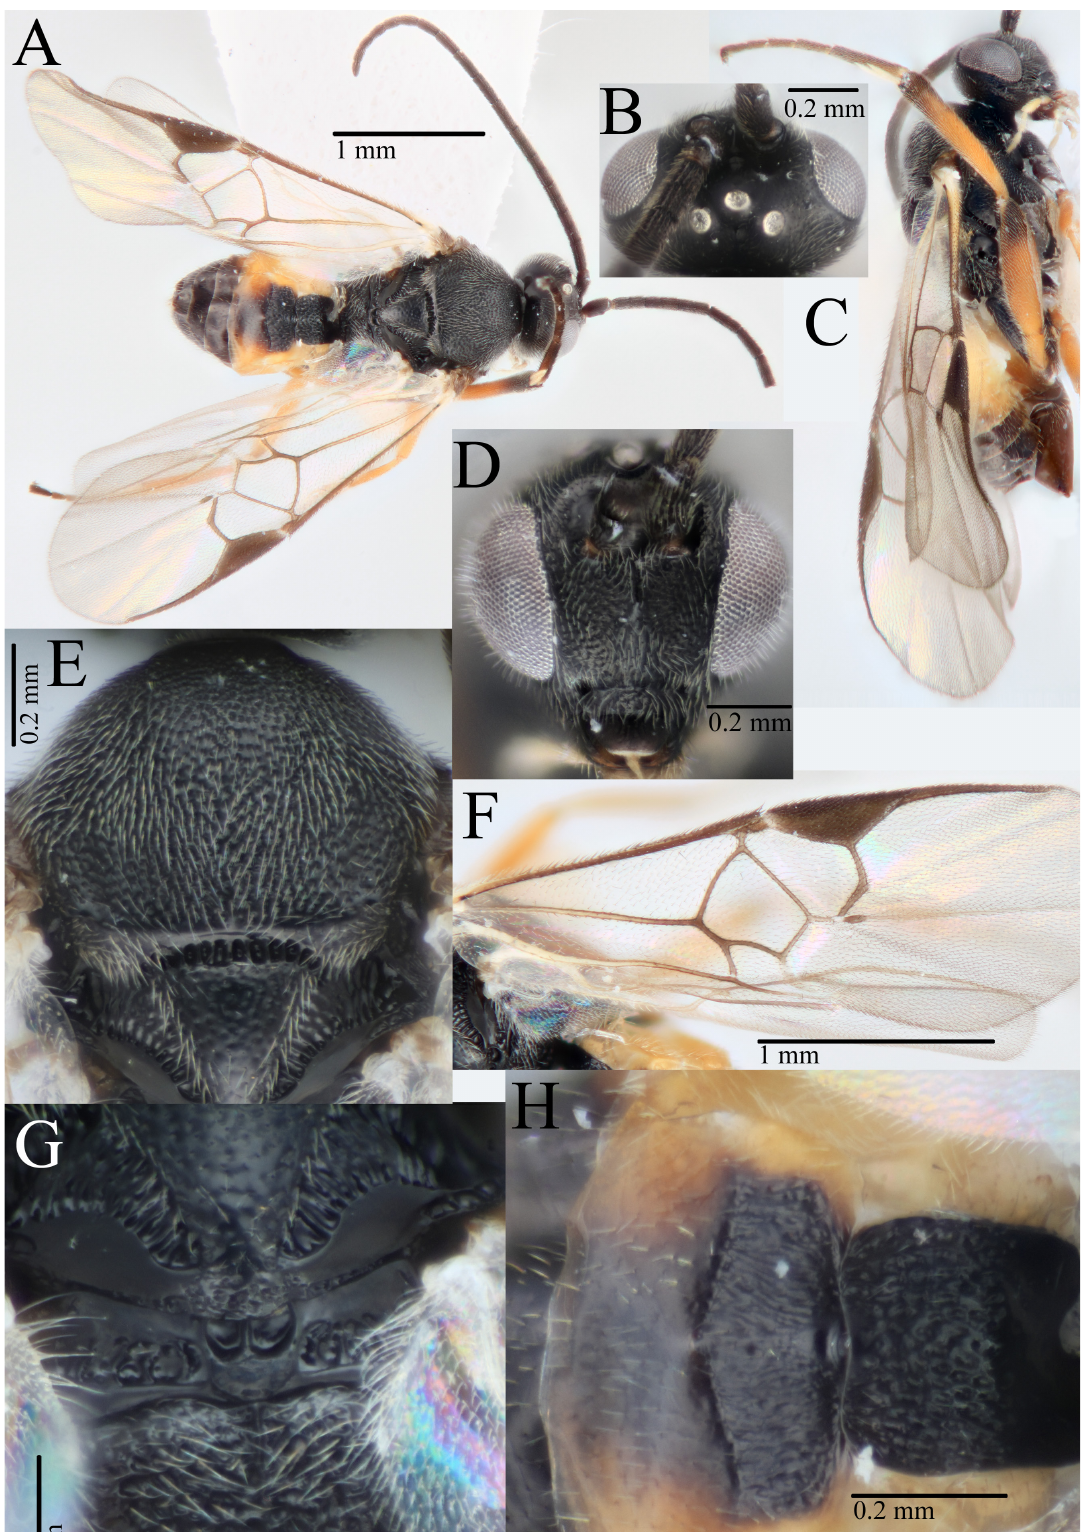
Fig. 33. Cotesia sp. nr C. icipe ., ♀ (Cox Scrub, S Australia) A . Habitus in dorsal view. B . Head in dorsal view. C . Habitus in lateral view. D . Head in anterior view. E . Anteromesoscutum. F . Fore wing. G . Posterior scutellar disk, mesoscutellum and propodeum. H .